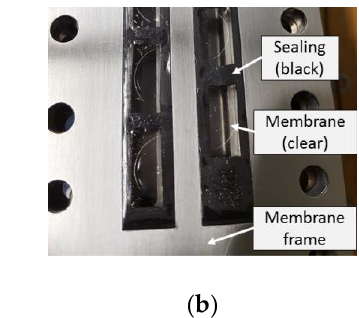
Figure 10. Overview of the experimental setup for continuous direct synthesis of H 2 O 2 with mass flow controller (MFC), pressure controller (PIC) and flow injection analysis (FIA).